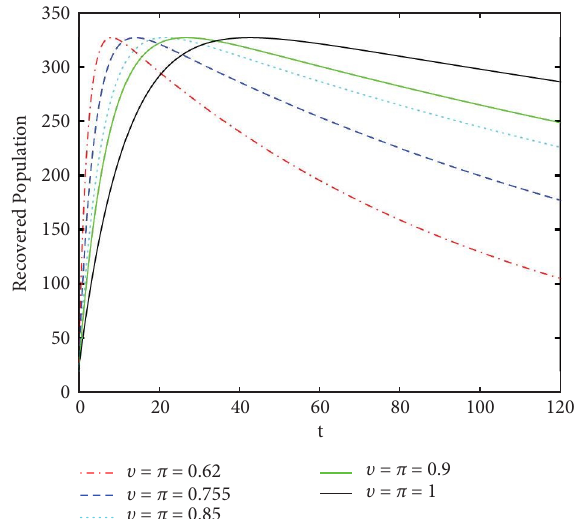
Figure 25: Te dynamics of recovered human population for various fractal-fractional